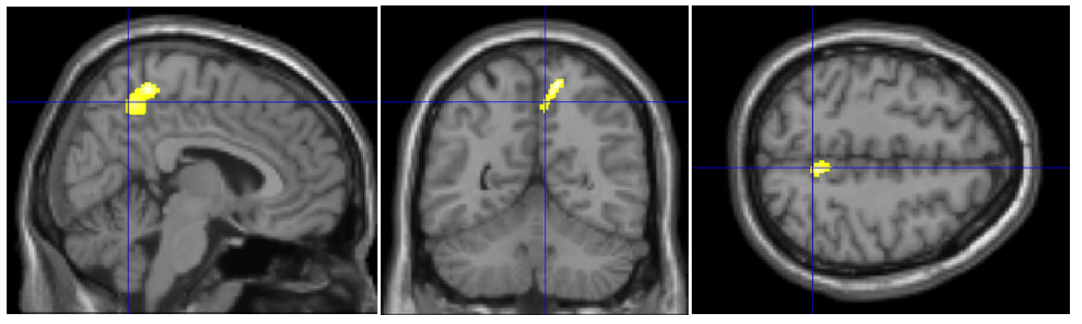
Figure 1. Comparison of rGMV between the two